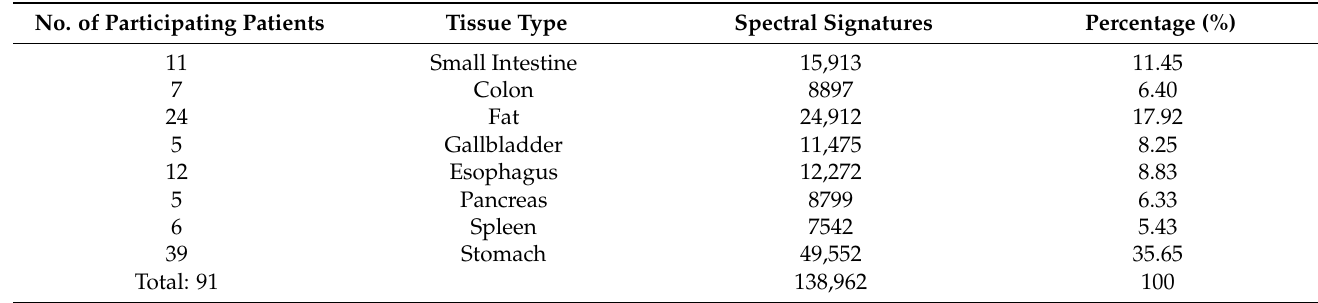
Table 2. Spectral data of the gastrointestinal